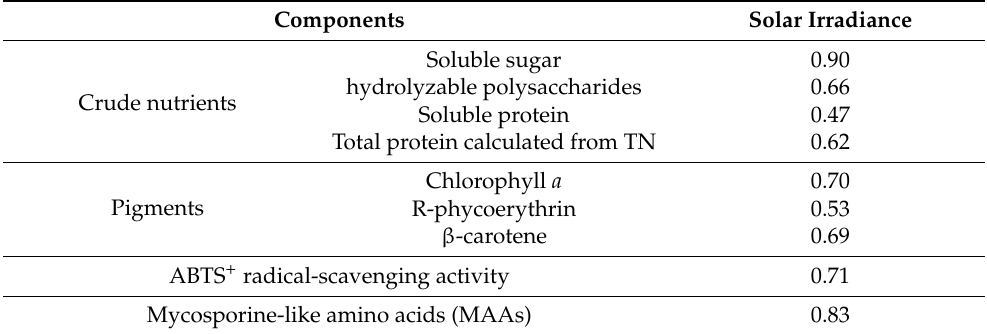
Table 3. Gray correlation coefficients between light intensity and algal composition components of the samples cultivated in the comparative